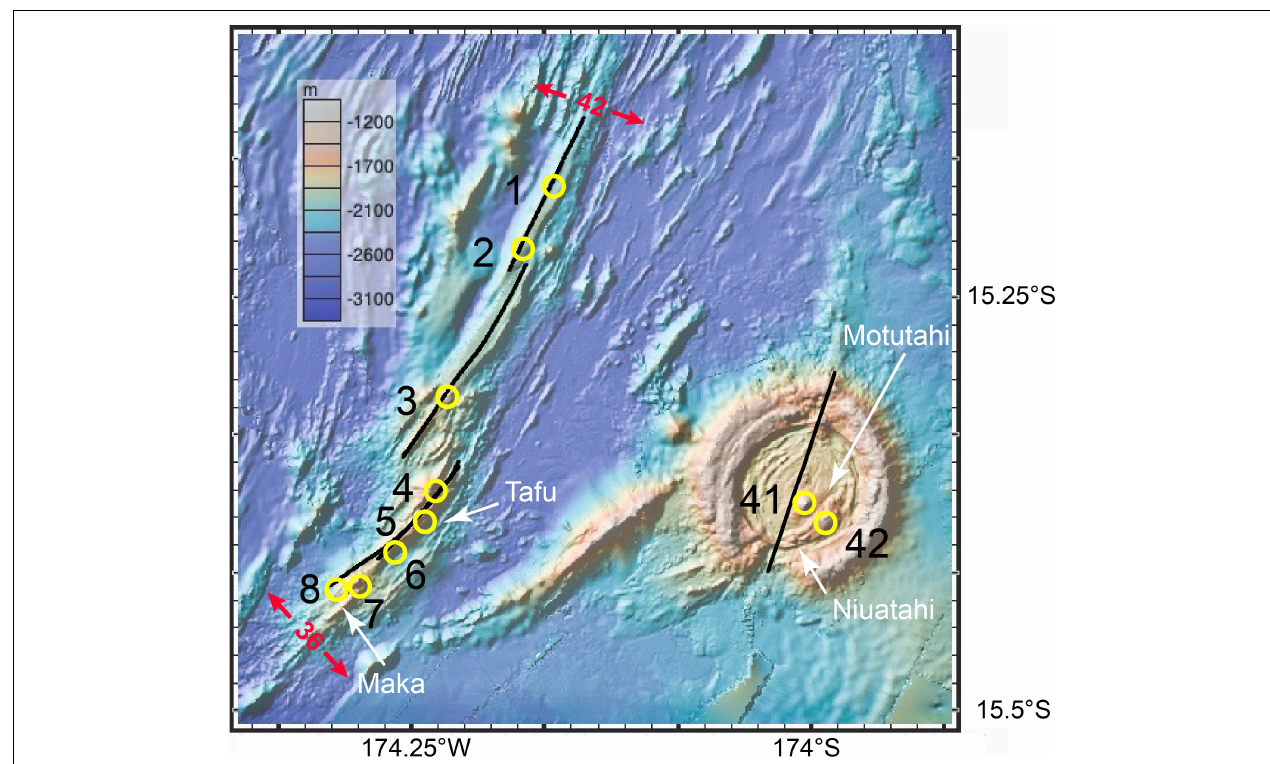
FIGURE 2 | Survey tow lines (black) and active hydrothermal sites (yellow circles) of the NELSC and the Niuatahi volcano (within which is the Motutahi volcanic cone). Numbers correspond to sites in Tables 1 , 2 . Red arrows indicate full rate spreading values (mm/year). Figure made with GeoMapApp (www.geomapapp.org).